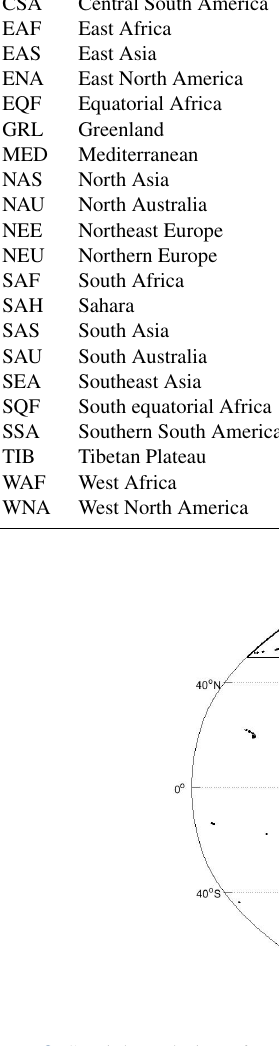
Figure 2. Spatial resolution of our analysis. “Giorgi regions” are from Giorgi and Bi